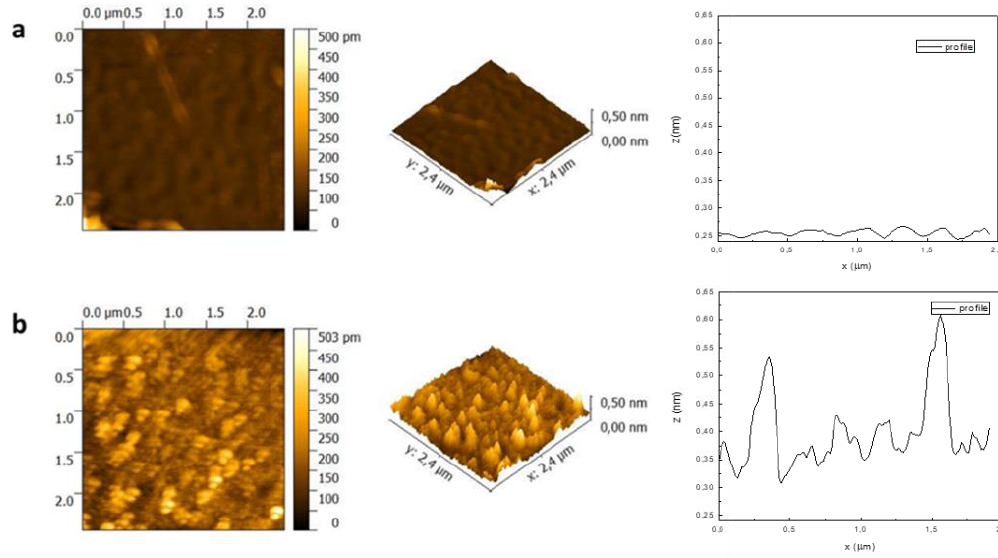
Figure 6. Atomic Force Microscopy (AFM) images of PNIPAM- b -PANI thin films: ( a ) before and ( b ) after NIR irradiation.